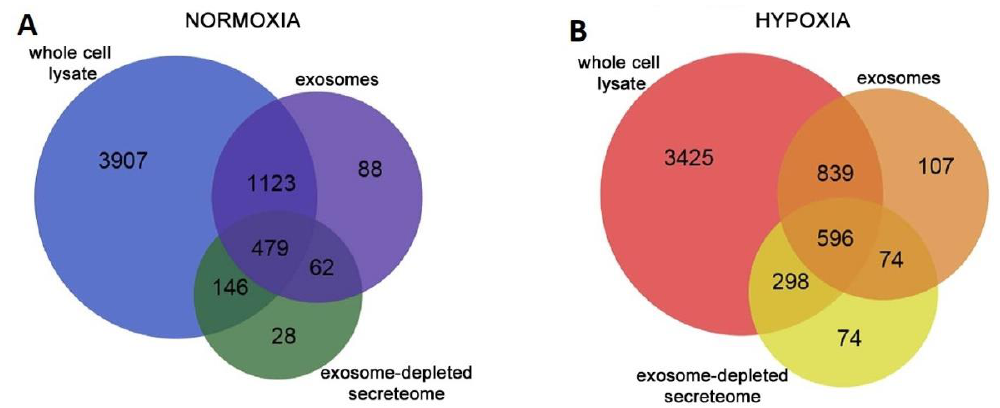
Figure 4. Summary of proteomics data acquired using a multidimensional protein identification technology approach. Venn diagrams representing the overlap of protein identifications between cardiac fibroblast (CF) whole-cell lysate, exosome, and secretome collected in ( A ) normoxic conditions and ( B ) hypoxic conditions. The number of proteins contained in the three fractions changed depending on the culture conditions. Modified from Reference [25].